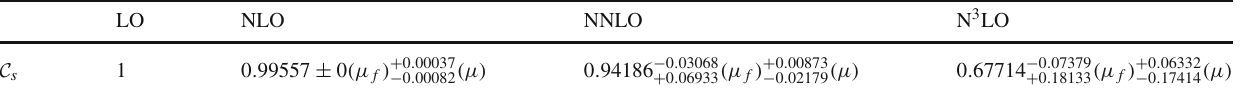
Table 1 The values of the matching coefficient C s for the flavor-changing heavy quark scalar current up to N 3 LO LO NLO NNLO N 3